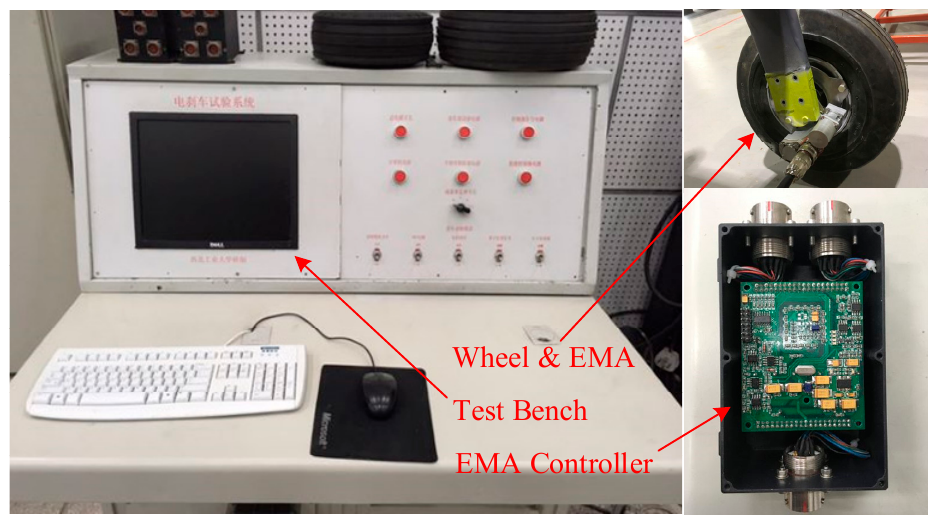
Figure 7. The HIL test bench of the electric braking system.